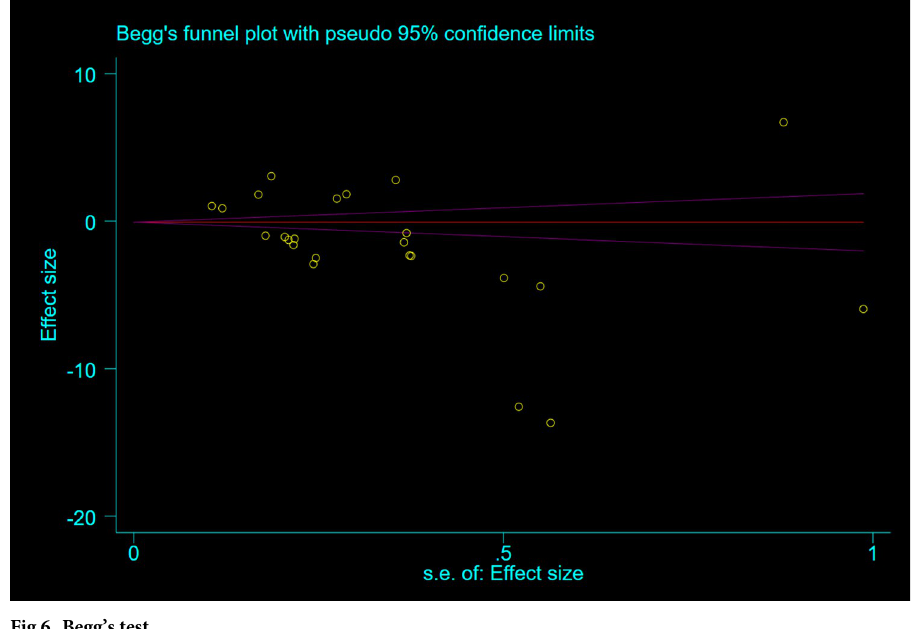
macrophages, promoting atherosclerosis by inhibiting expression of the mouse target gene B- cell lymphoma 6 protein. Yulan Ma et al. [24] also found increased expression of microRNA- 155 in oxLDL-activated RAW264.7 cells and that increased microRNA-155 induced expression